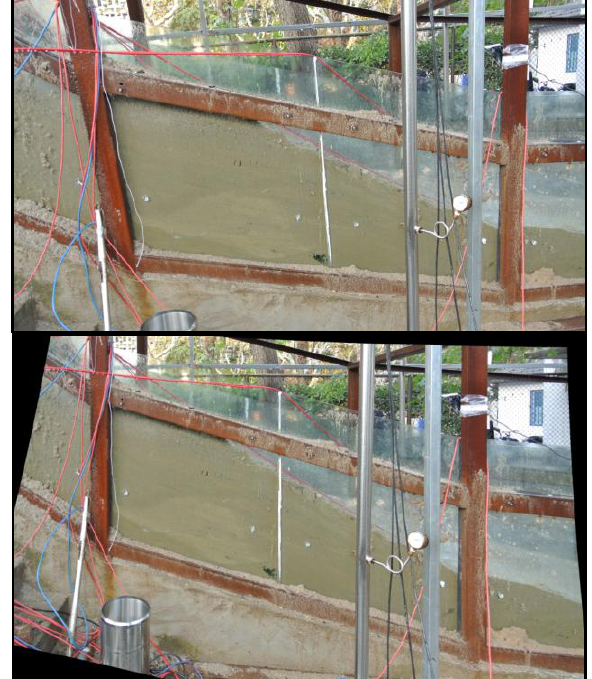
Figure 4. One of the images of the sequence (the one used as master) before (at top) and after rectification (at